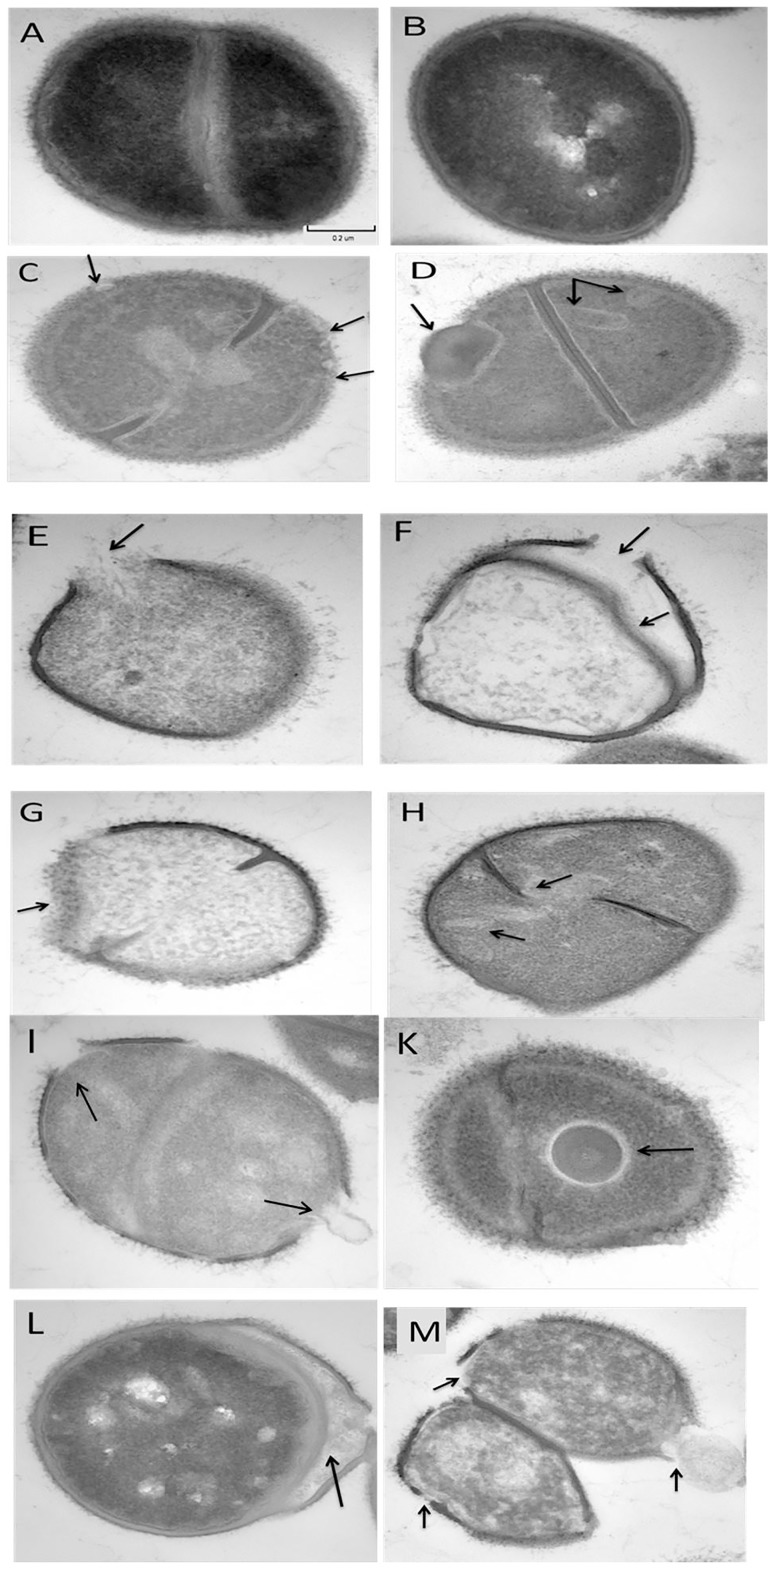
Transmission electron microscopy (TEM) micrographs of untreated and peptide treated S. pseudintermedius (SP3).Control bacteria either dividing cells (A) or single celled (B), the cells are round and intact, with a well-defined cell membrane. The intracellular DNA region exhibits a highly inhomogeneous electron density. C&D: 1X MIC RRIKA; E&F: 10X MIC RRIKA, G: 10X MIC RR; H: 10X MIC (KFF)3K; I: 10X MIC IK8 “D isoform”; K: 10X MIC WR-12; L: 1X MIC penetratin; M: 10X MIC penetratin.